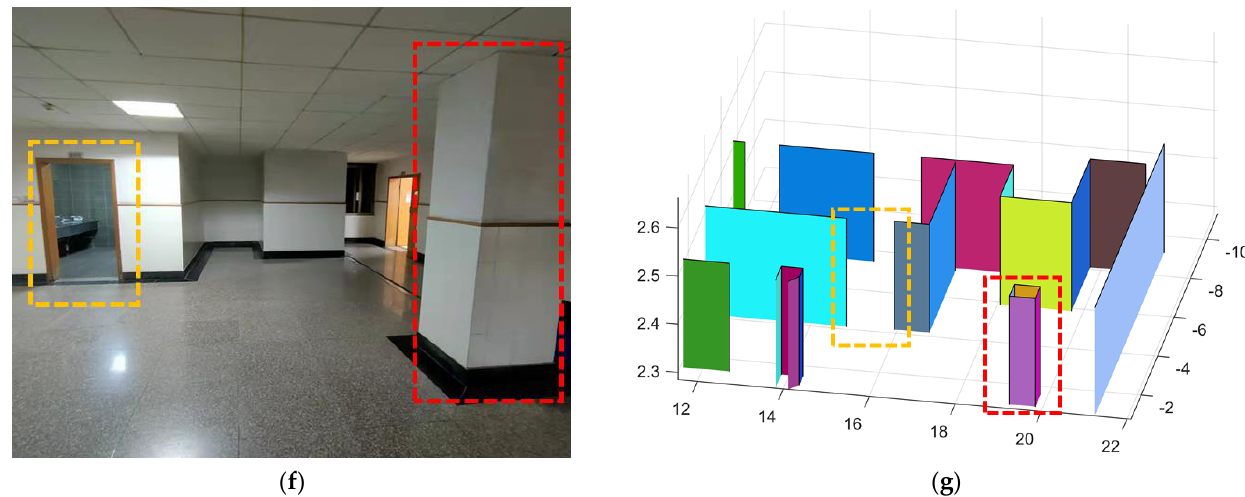
Figure 23. The resulting presentation of scene 2: ( a ) point cloud data of scene 2; ( b ) the experimental results obtained by our algorithm; to better show the interior, we removed the ceiling; ( c ) we provide the two-dimensional plan of the floor and mark out the rooms, the toilets, the safe passage, and our movements; the gaps between the lines are the doors; ( d ) and ( e ) are the first part of the real scene and the comparison of experimental results; ( f , g ) are the second part of the real scene and the comparison of experimental results.